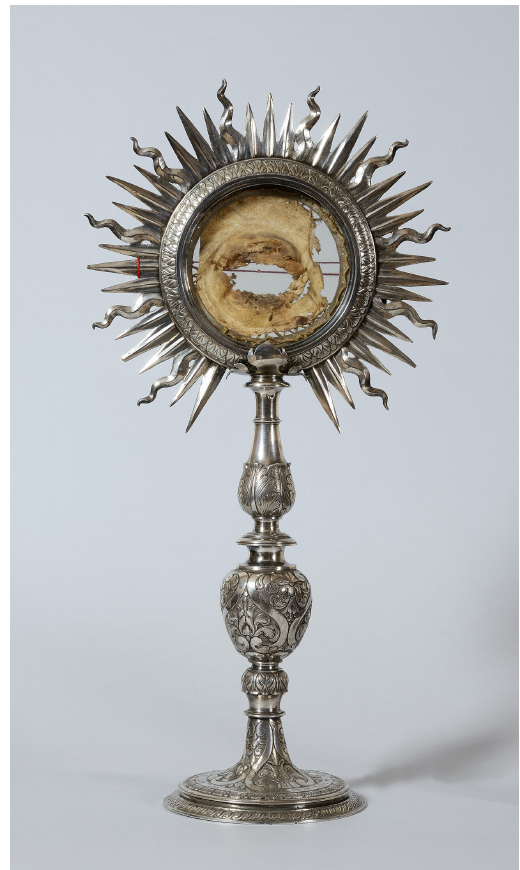
Figure 4 . Reliquary and relic of the camoscio , 1602, silver, height 44 cm, Relic Museum, Lower Church, Basilica of St. Francis, Assisi (photo: © Archivio fotografico del Sacro Convento di S. Francesco in Assisi,